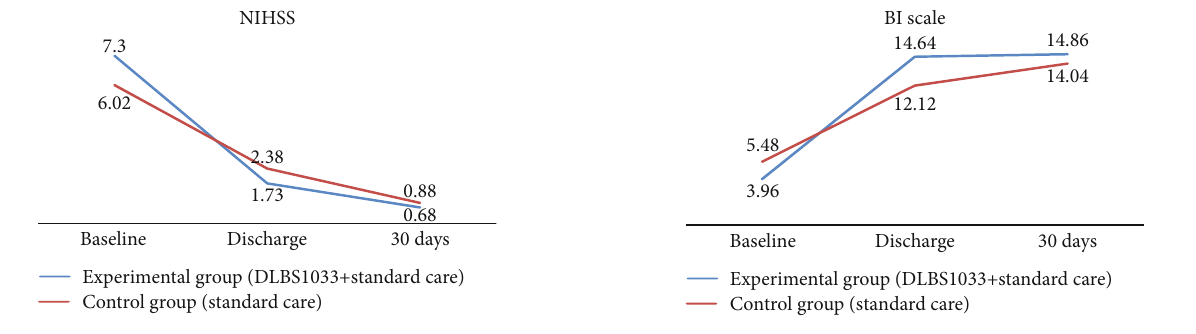
Figure 3: Change from baseline in the mean average Barthel Index (BI) score during the treatment period and follow-up